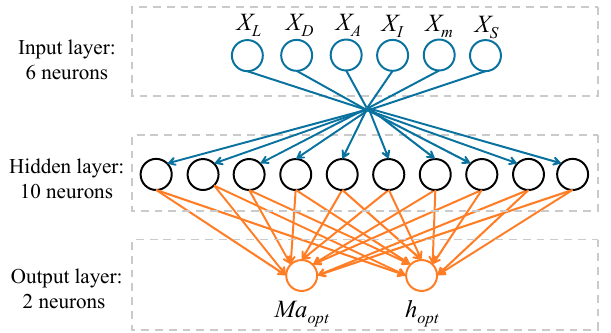
Figure 12. The structure of FFNN.